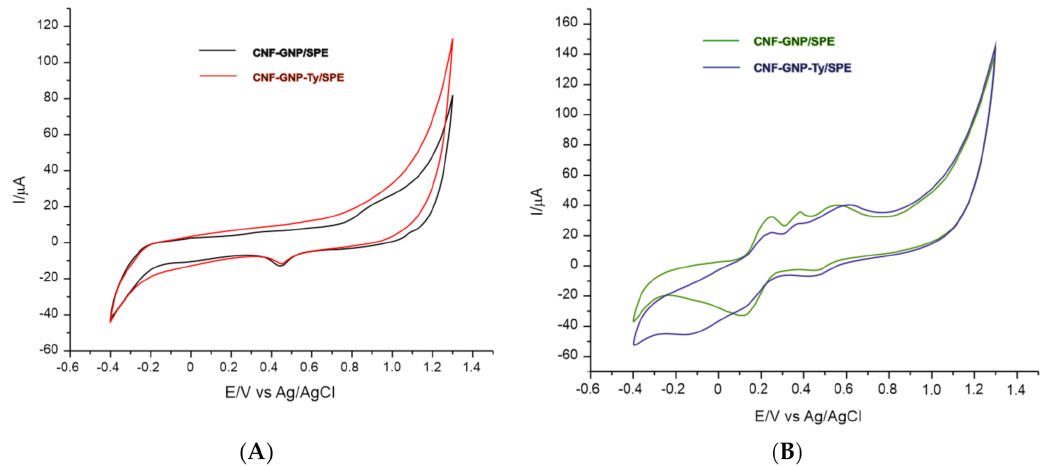
Figure 2. ( A ) Cyclic voltammograms of the CNF-GNP / SPE (black line) and the CNF-GNP-Ty / SPE (red line) in 10 − 1 M PBS solution (pH 7.0). ( B ) Cyclic voltammograms of the CNF-GNP / SPE (green line) and the CNF-GNP-Ty / SPE (blue line) in 10 − 3 M ferulic acid–10 − 1 M PBS solution (pH 7.0). Scan rate: 0.1 V · s − 1